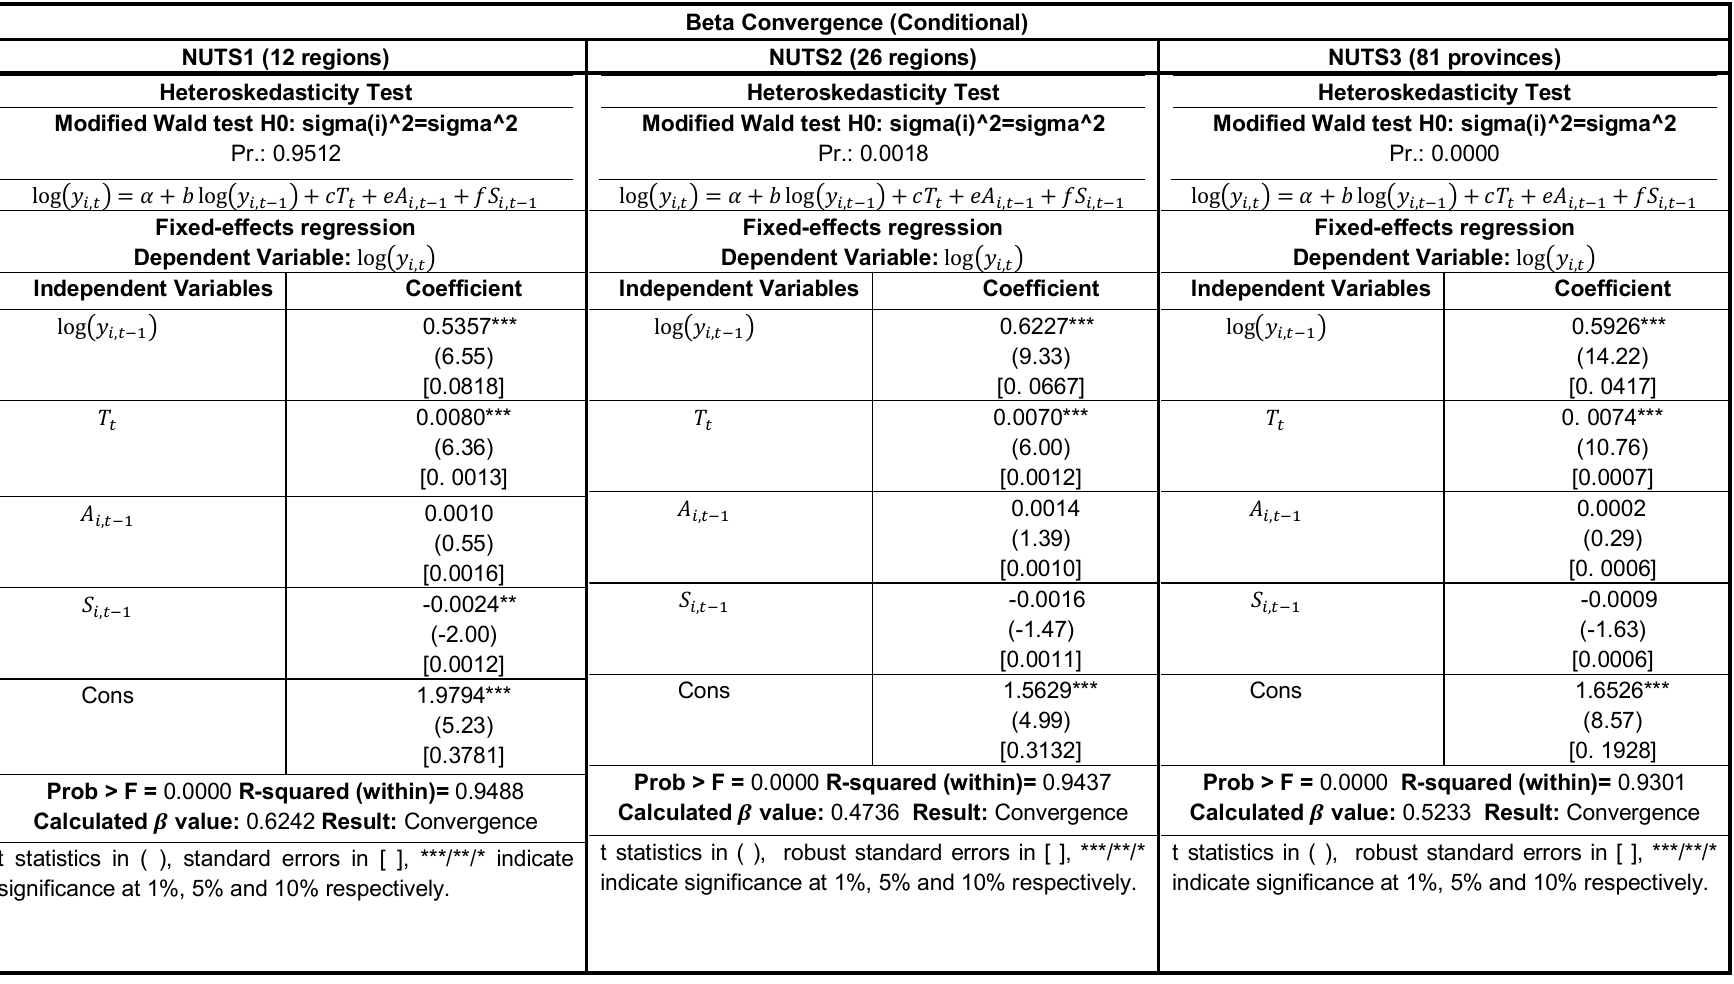
Table 2: Beta Convergence